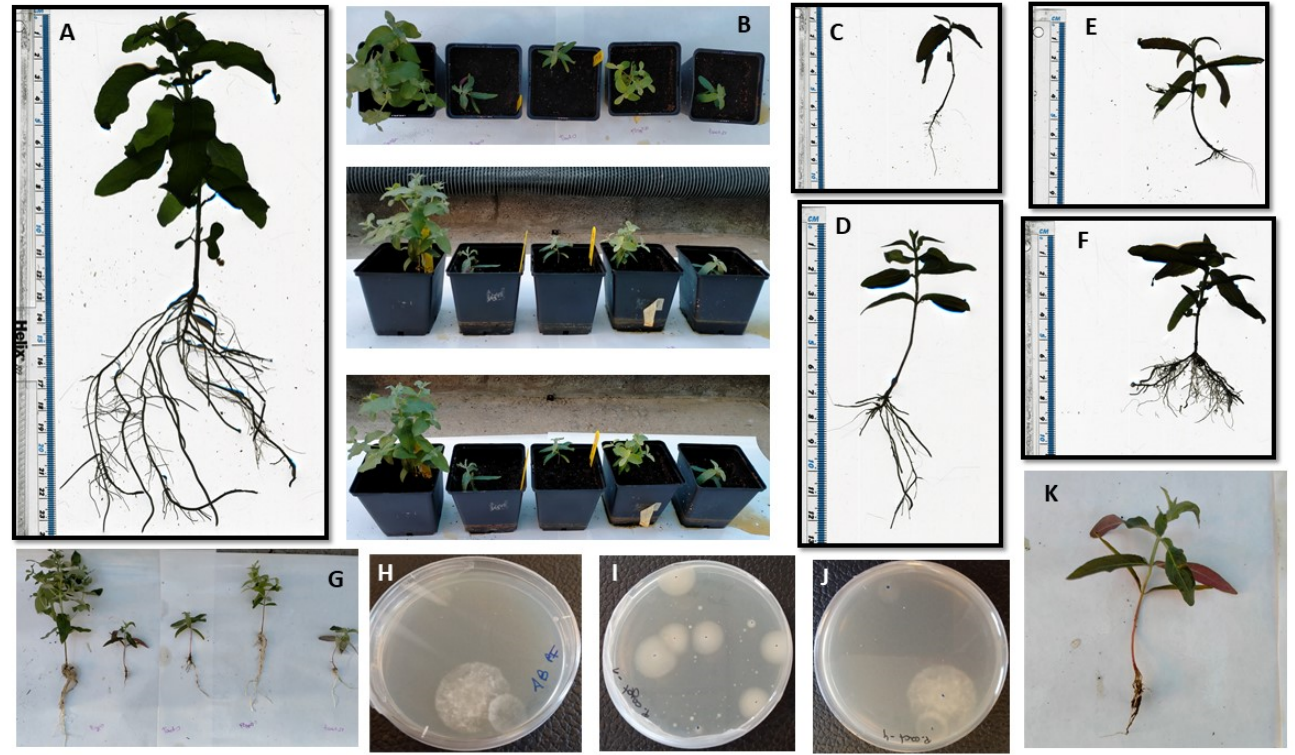
Figure 6. Pathogenicity assay with Eucalyptus globulus and colony forming unit counts: ( A ) root scanner image of an Eucalyptus globulus control plant; ( B ) in planta inoculated E. globulus plants shown at different angles with, from left to right: control; Phytophthora cryptogea 0; P. cactorum 0; P. cryptogea 21 ; and P. cactorum 21 ; ( C – F ) root scanner images of E. globulus inoculated with P. cryptogea 0 ( C ); P. cryptogea 21 ( D ); P. cactorum 0 ( E ); and P. cactorum 21 ( F ). ( G ) Plant and root system of inocu- lated E. globulus plants, from left to right: control, P. cryptogea 0, P. cactorum 0, P. cryptogea 21, and P. cactorum 21. ( H ) CFU (dilution 10 − 4 ) peat-free substrate inoculated with P. cactorum ; ( I ) CFU peat-based substrate inoculated with P. cryptogea (total in sample × CFU/g dry wt); ( J ) CFU (peat- based substrate inoculated with P. cactorum (total in sample × CFU/g dry wt; ( K ). E. globulus plant inoculated with P. cryptogea